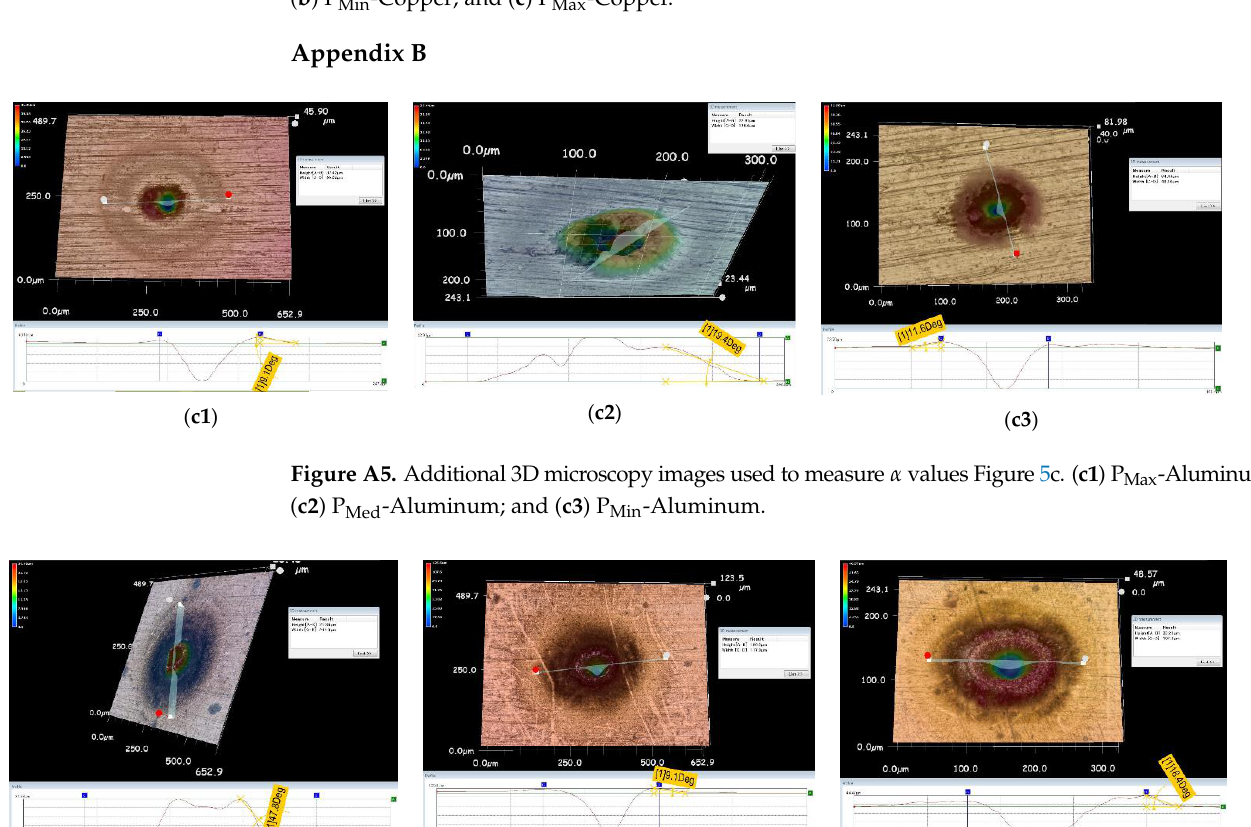
Figure A4. A series of differing perspectives for the PCA analysis of Figure 8. ( a ) P Med -Copper; ( b ) P Min -Copper; and ( c ) P Max -Copper.